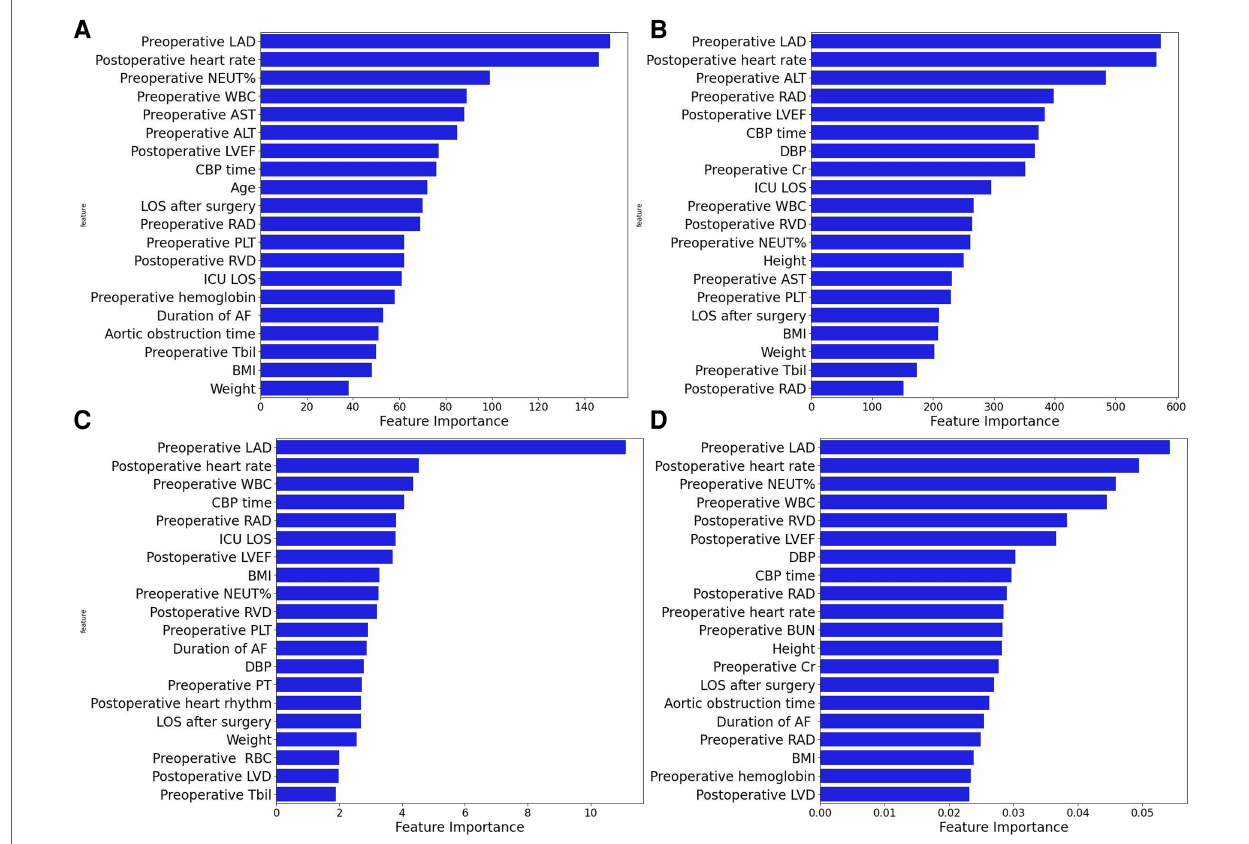
FIGURE 4 The feature importance plots of 4 machine learning models from the Non-CMP-IV group are shown in A – D . The models used are XGBoost ( A ), LightGBM ( B ), CatBoost ( C ), and Random Forest ( D